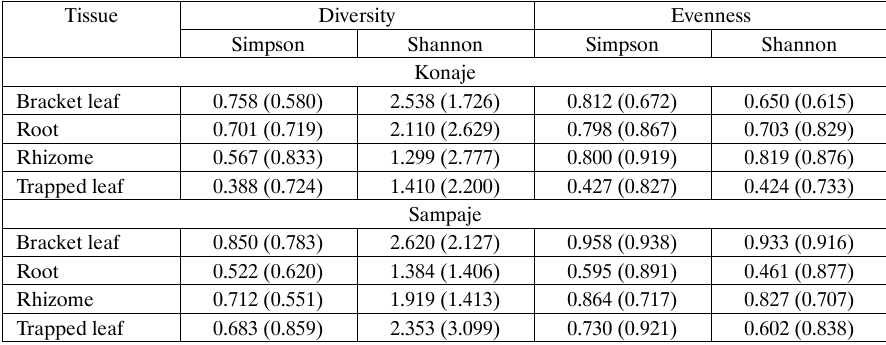
Diversity and evenness of water-borne hyphomycetes in tissues of Drynaria and trapped leaves during summer and monsoon (in parenthesis) in Konaje and Sampaje